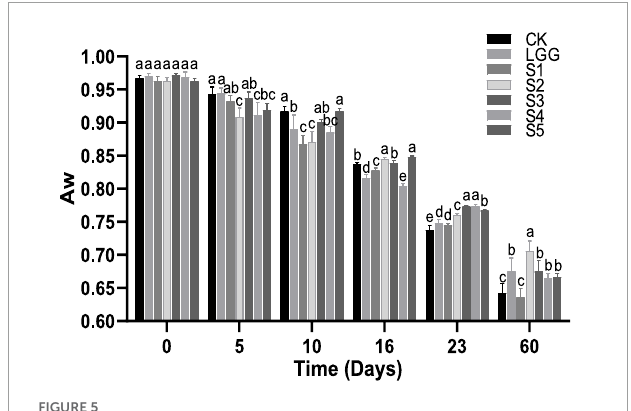
FIGURE5 Evolution of a w value during the ripening of the different samples of sausage. Different letters indicate that a w value of fermented sausage in different groups has significant difference at the same time ( p <